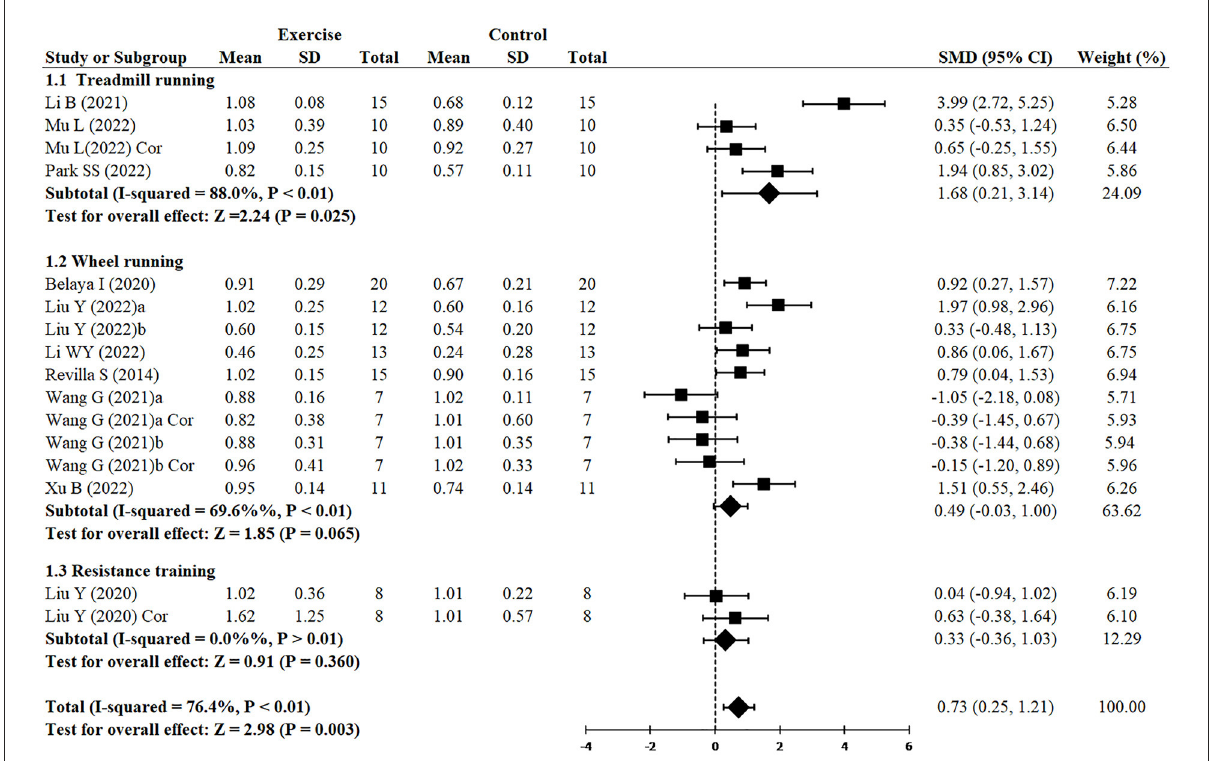
FIGURE5 Subgroup analysis of exercise type on the expression of PSD95 in AD